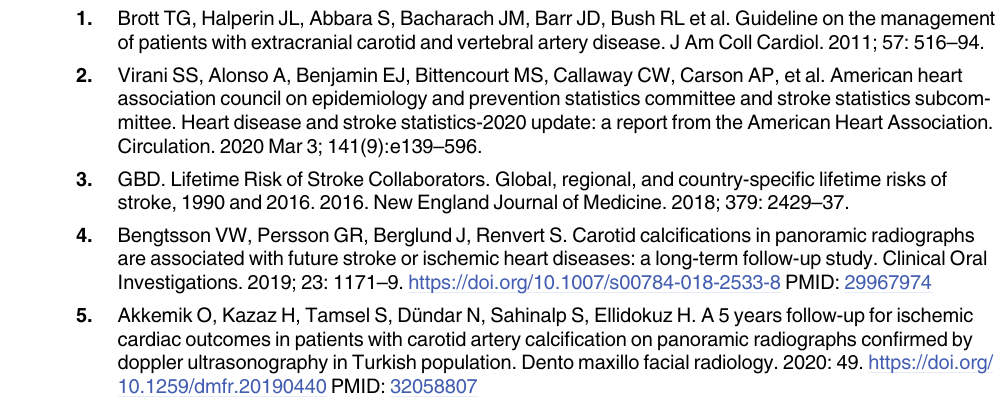
S3 Fig. Figures E and F are panoramic corners with Triticeous Cartilage calcification. The blue arrows point toward the calcification. Figures G and H are clean normal corners. (TIF) S4 Fig. MapGrad of calcified corners. (TIF) S5 Fig. MapGrad of clean corners.